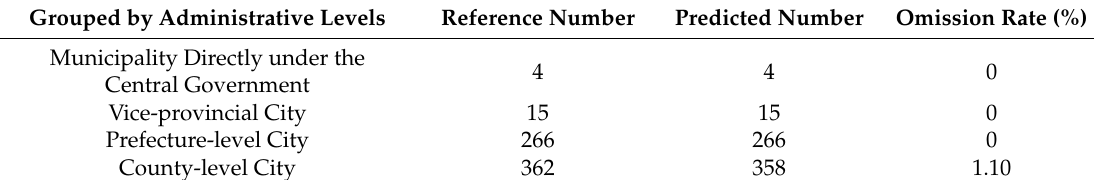
Table 3. Error matrices and accuracy assessment for urban and non-urban land cover types.